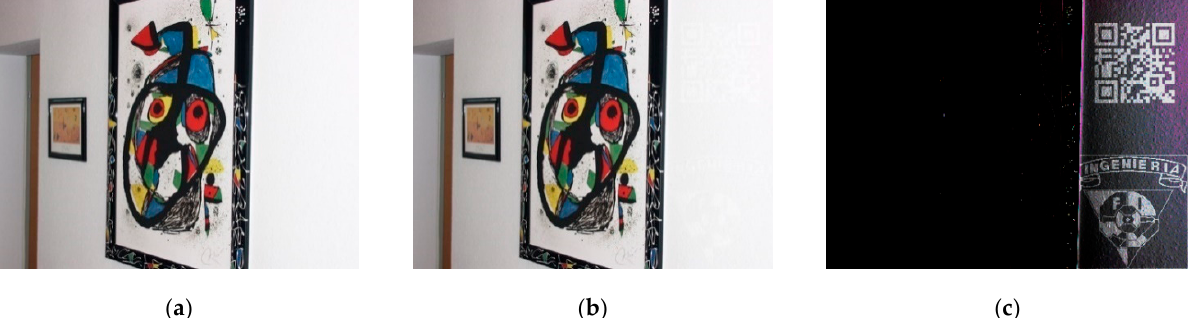
Figure 14. Double-watermarked image used to evaluate the robustness of the proposed algorithm against common geometric attacks: ( a ) original image, ( b ) watermarked image by QR code and owner logotype, PSNR = 47.33 dB, SSIM = 0.9926, NCD = 0.0072, ( c ) exhibited watermarks.